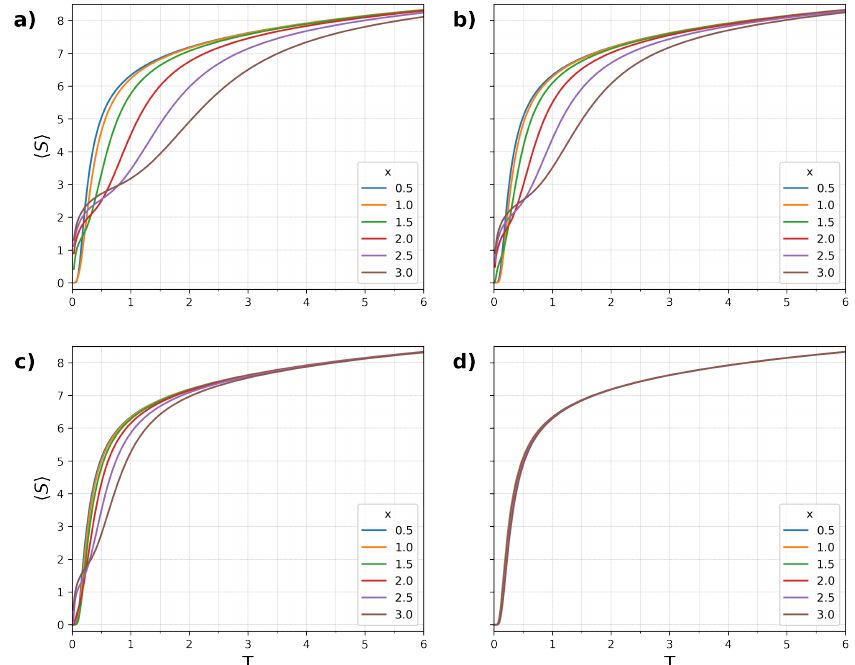
Figure 2. The behavior of the entropy is displayed as a function of the temperature. The curves correspond to different values of the a-dimensional coupling constant x . From left to right, the values of x take the values 0.5, 1, 1.5, 2, 2.5, and 3, respectively. ( a – d ) stand for values of the asymmetry parameter α = 1, 1.5, 0.5, and 0.1, respectively.